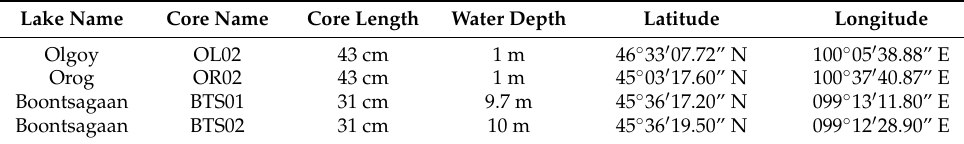
Table 1. Sediment-core